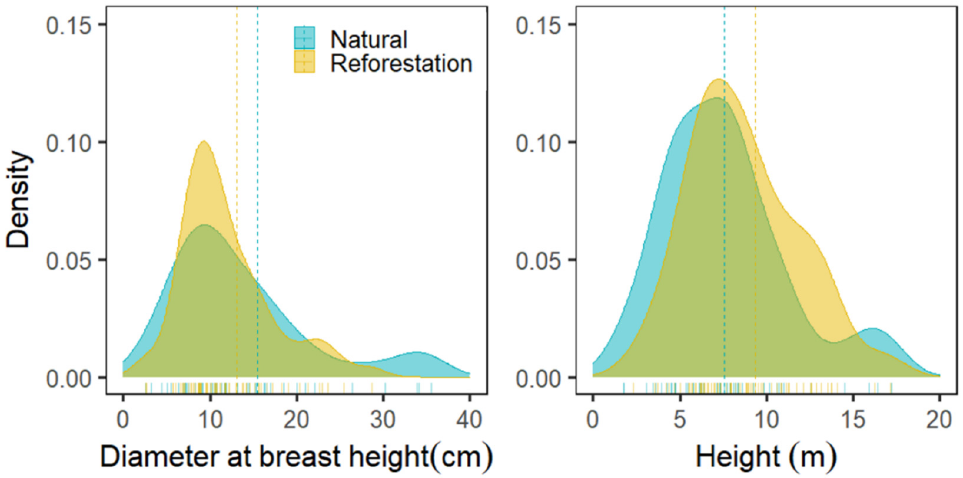
Figure 4. Kernel Density histogram of diameter at breast height (DBH, left panel) and height ( right panel) of tree species in the natural and reforestation sites.